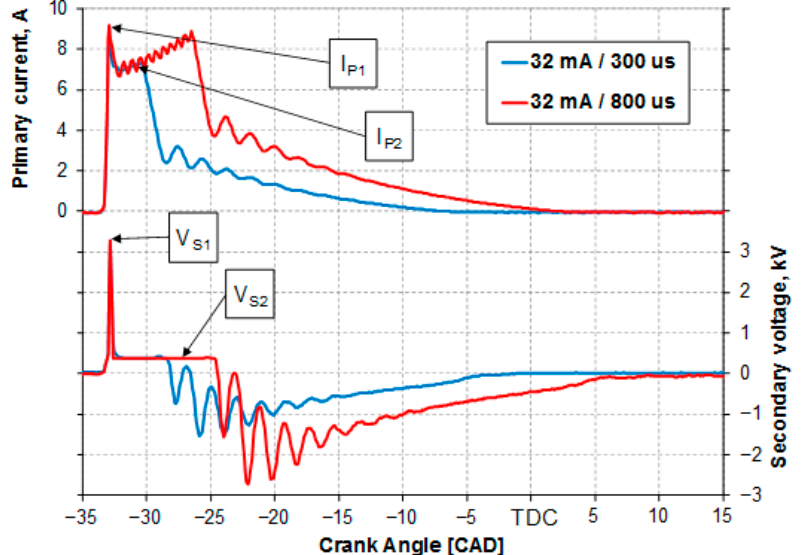
Figure 5. Primary coil circuit current and secondary coil circuit voltage, for two different spark duration conditions (300 and 800 µ s) with the same target current intensity on the secondary (32 mA) with MIX EQ2.